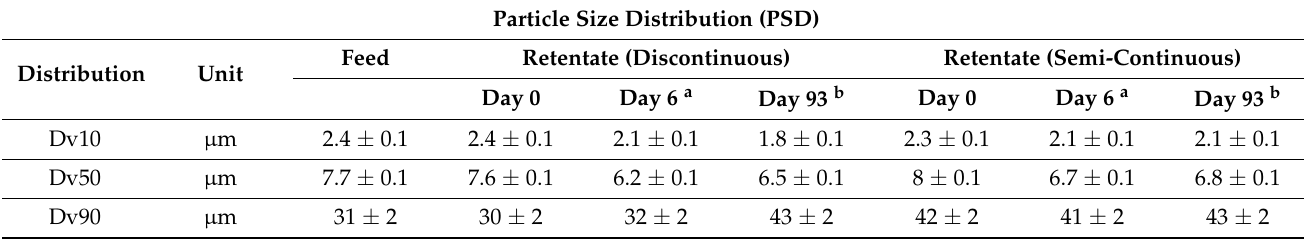
Table 6. Particle size distribution (volume-based) of naproxen crystals in suspension before (feed) and after (retentate) the solvent